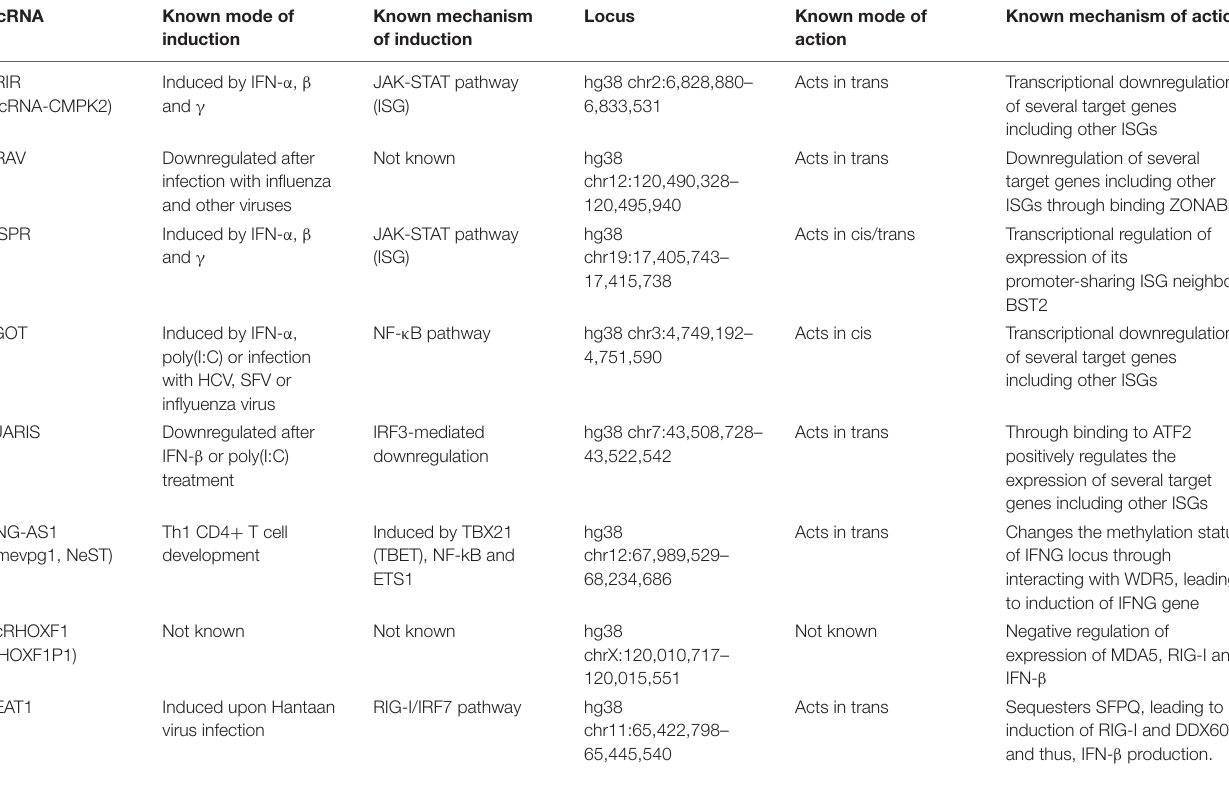
TABLE 1 | Summary of the mode of induction and action of the lncRNAs involved in regulation of the IFN response.